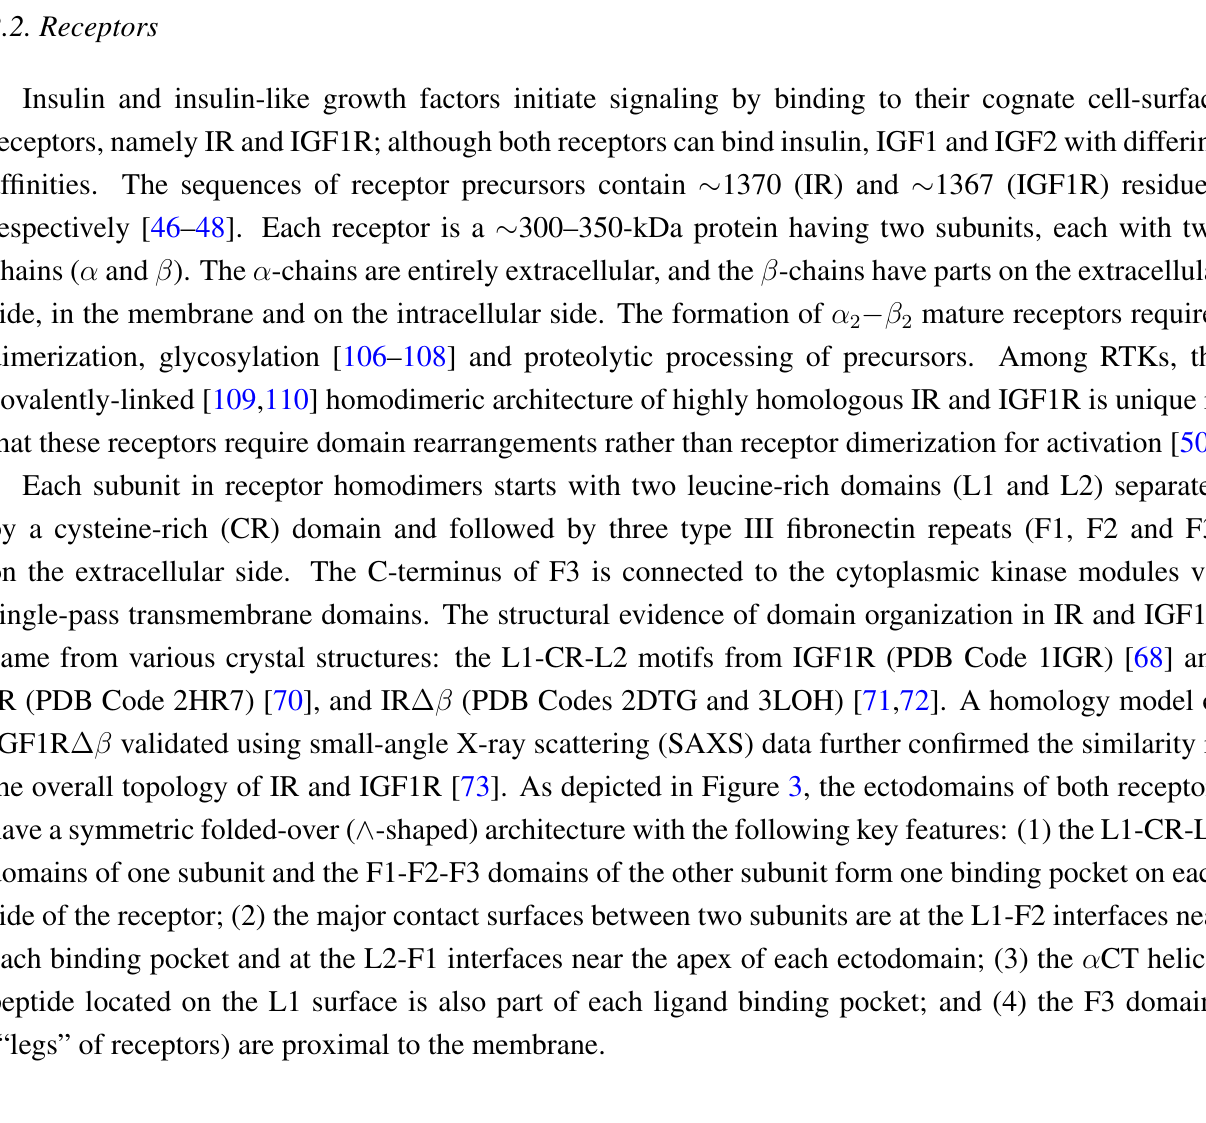
Figure 2. Three allosteric forms of insulin hexamers. T are shown in cartoon representations. The color scheme for the insulin monomers is the same as in Figure 1. Additionally, six zinc-coordinating histidine residues from six B chains (cyan) and six phenols (magenta; R bonds are omitted for